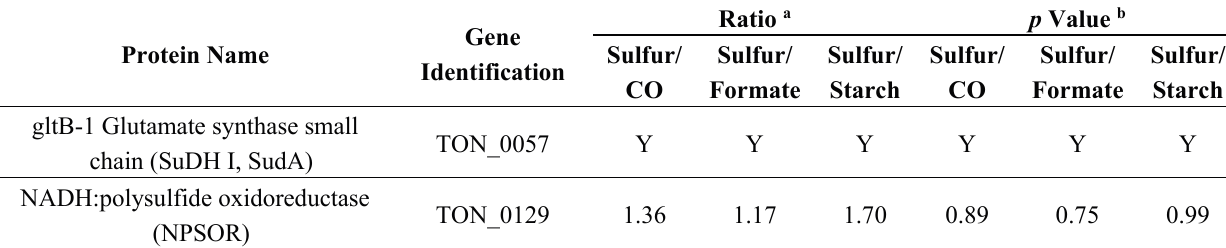
Figure 1. Functional categorization of the differentially expressed proteins as a function of the specific response to sulfur (Arrows indicates positive regulation, whereas bars indicate negative regulation). Table 2. Relative abundance of representative up-regulated proteins in T. onnurineus NA1 cells grown on sulfur compared with those grown on CO, formate, and starch. (Y, only detected in Sulfur; S, only detected in Starch; C, only detected in CO; F, only detected in